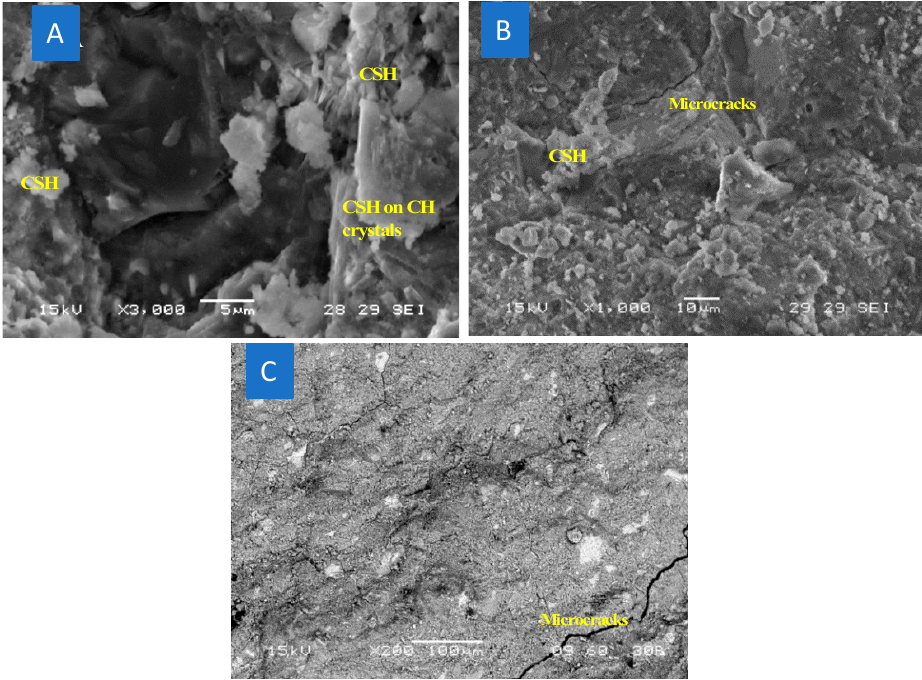
Figure 13. BSC micrograph of B1-PC86LS14 28D at ( A ) 3000× magnification, ( B ) 1000× magnification and ( C ) 100× magnification.